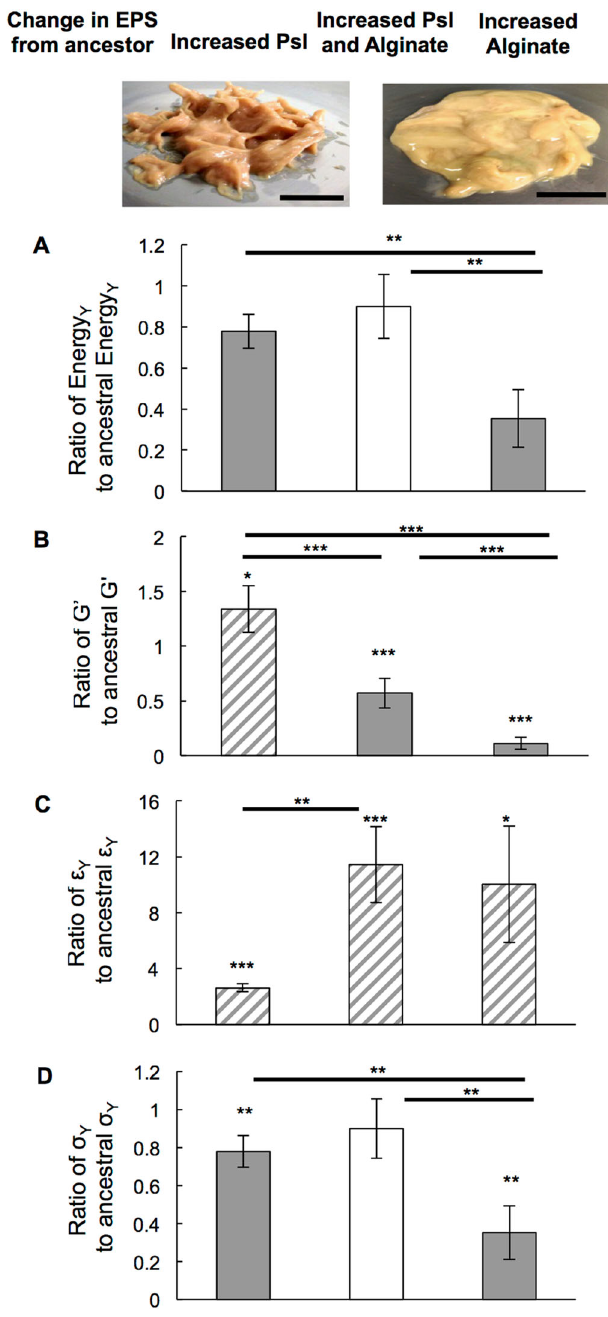
Fig. 2 Evolutionary changes in the mechanical properties of bio fi lms grown from clinical bacterial isolates, distinguished by whether the isolate strain evolved to increase Psl production, increase production of both Psl and alginate, or increase production of alginate, compared with its initially-isolated ancestor. Mechanical changes from the bio fi lm grown by each strain ’ s ancestor are measured by taking the ratio of the mechanical property measured for the evolved strain to the corresponding property measured for the ancestor. Thus, a ratio of one indicates no change, a ratio greater than one indicates an increase with evolution, and a ratio less than one indicates a decrease with evolution. Grey highlights diminished mechanics and striped indicates enhanced mechanics. Inset photos show representative images of pooled bio fi lms that over-express Psl ( left ) and alginate ( right ). The mechanical difference between